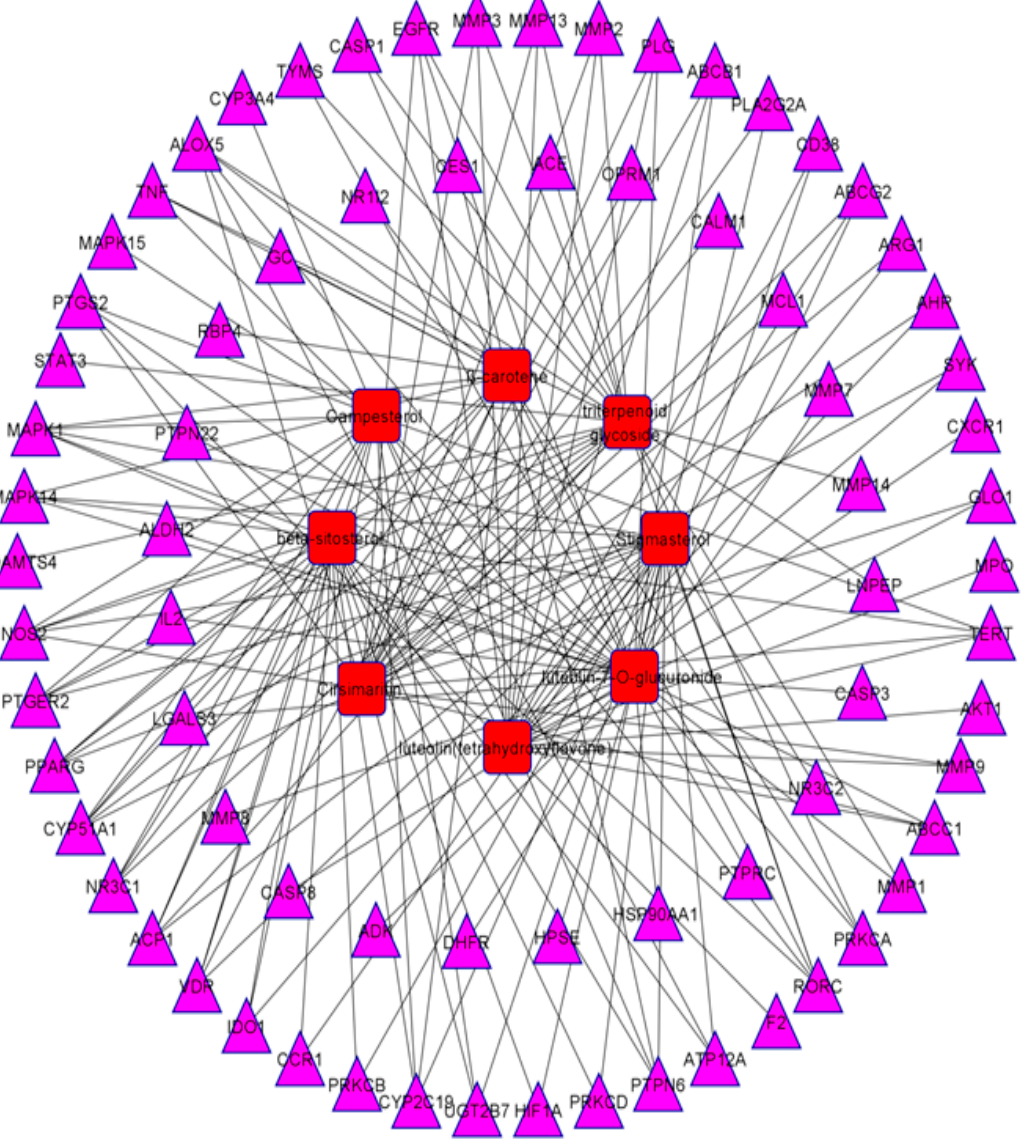
Figure 4. Compound-target network between active compounds and common targets of disease and compounds (red color shows active ingredients and purple color shows potential targets).